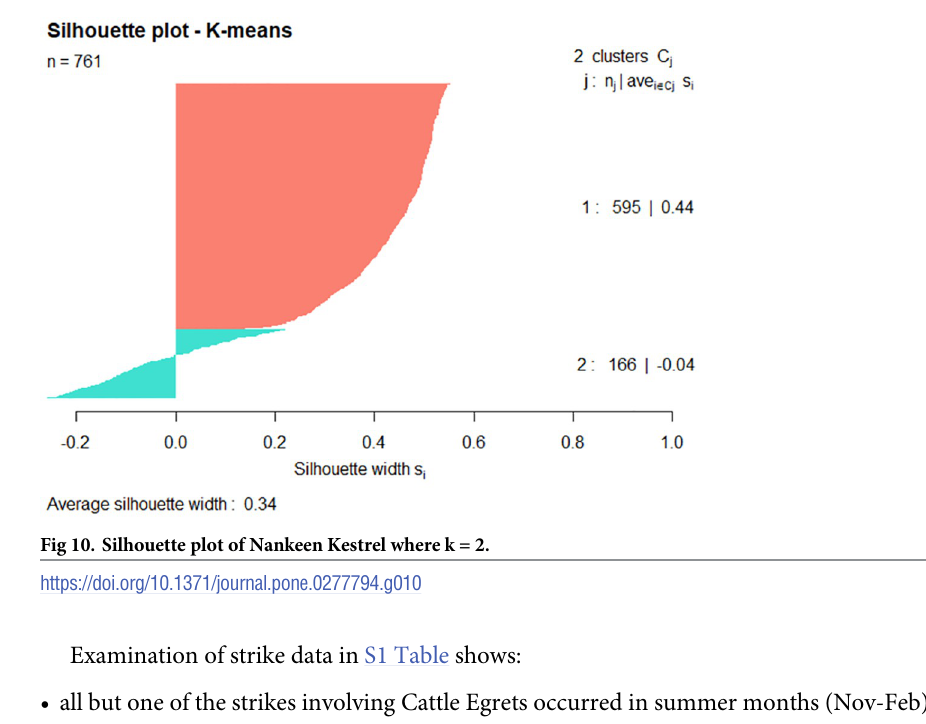
Examination of strike data in S1 Table shows: